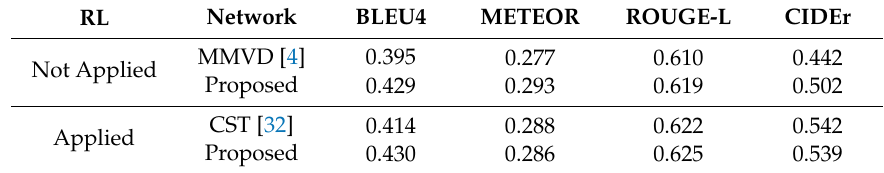
Table 4. Description performance of MMVD [4], CST [31], and the proposed